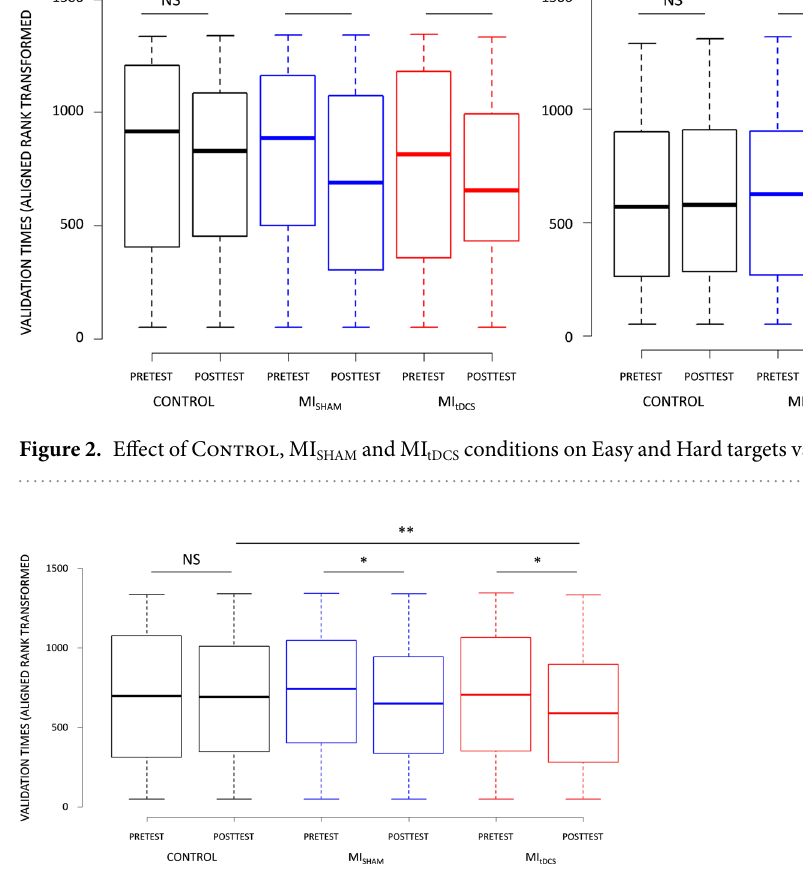
Figure 3. Effect of Control, MI SHAM and MI tDCS conditions on postural task